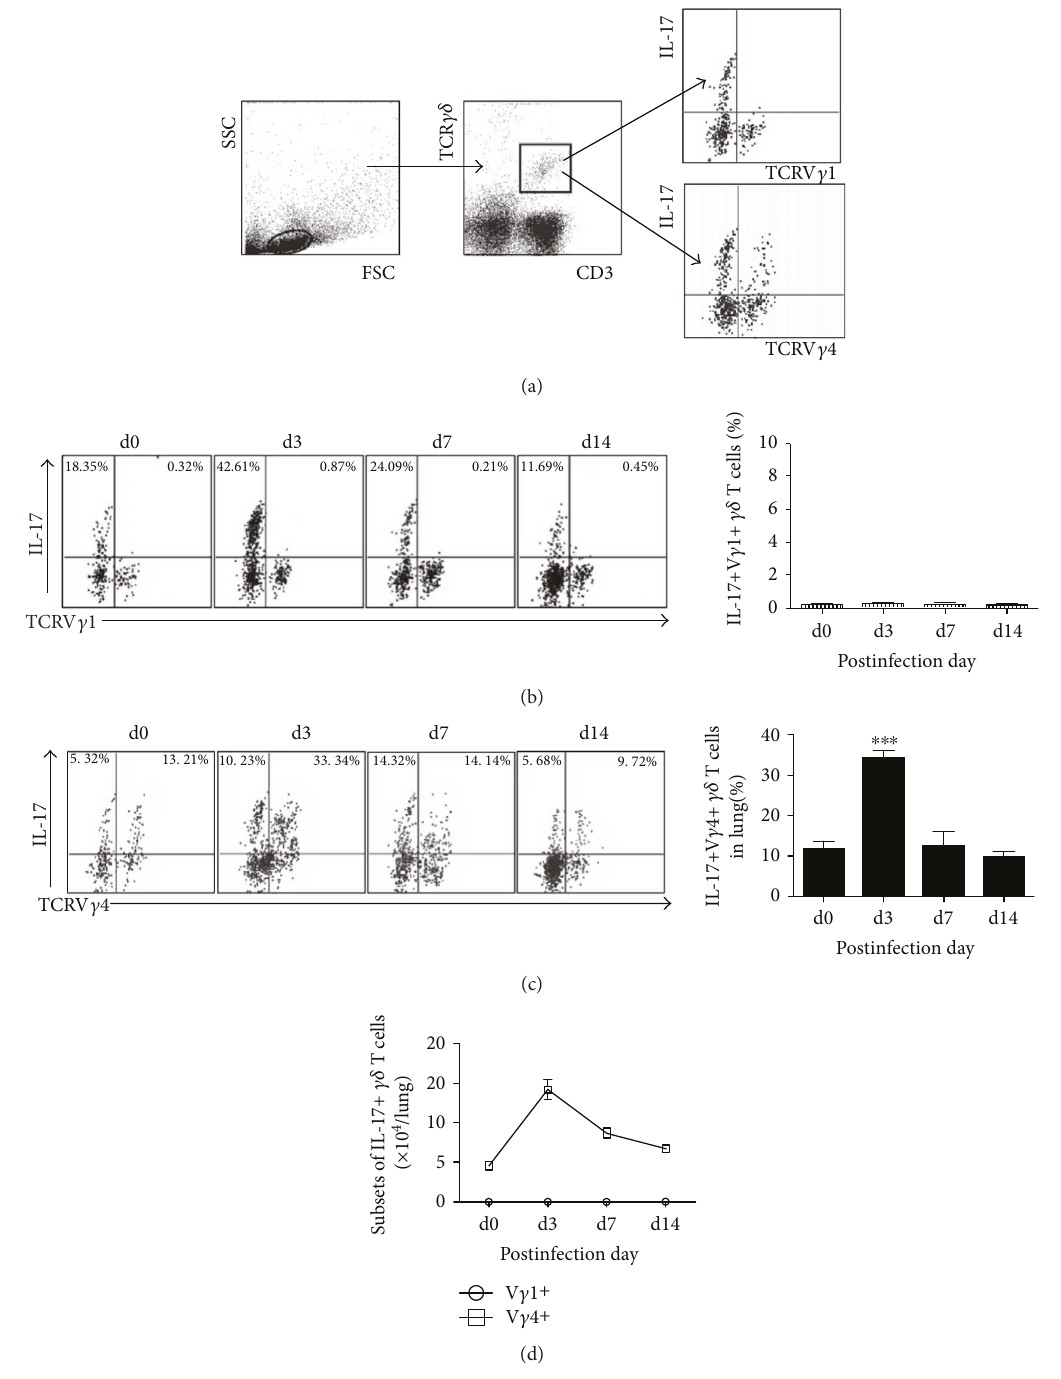
Figure 5: V γ 4 cells at day 3 p.i. are the major sources of IL-17 during Cm lung infection. IL-17+ V γ 4+/V γ 1+ T cells were gated (a), stained with anti-mouse CD3, TCR γδ , TCRV γ 4, and IFN γ /IL-17 antibody to analyze percentage of Il-17+ V γ 1+ T cells (b) and IL-17+ V γ 4+ T cells (c) in lung tissues after Cm infection. Comparison between IL-17+ V γ 1+ cell and IL-17+ V γ 4+ cell with its absolute number (d). The results are presented as mean ± SD. ∗∗∗ p < 0 001